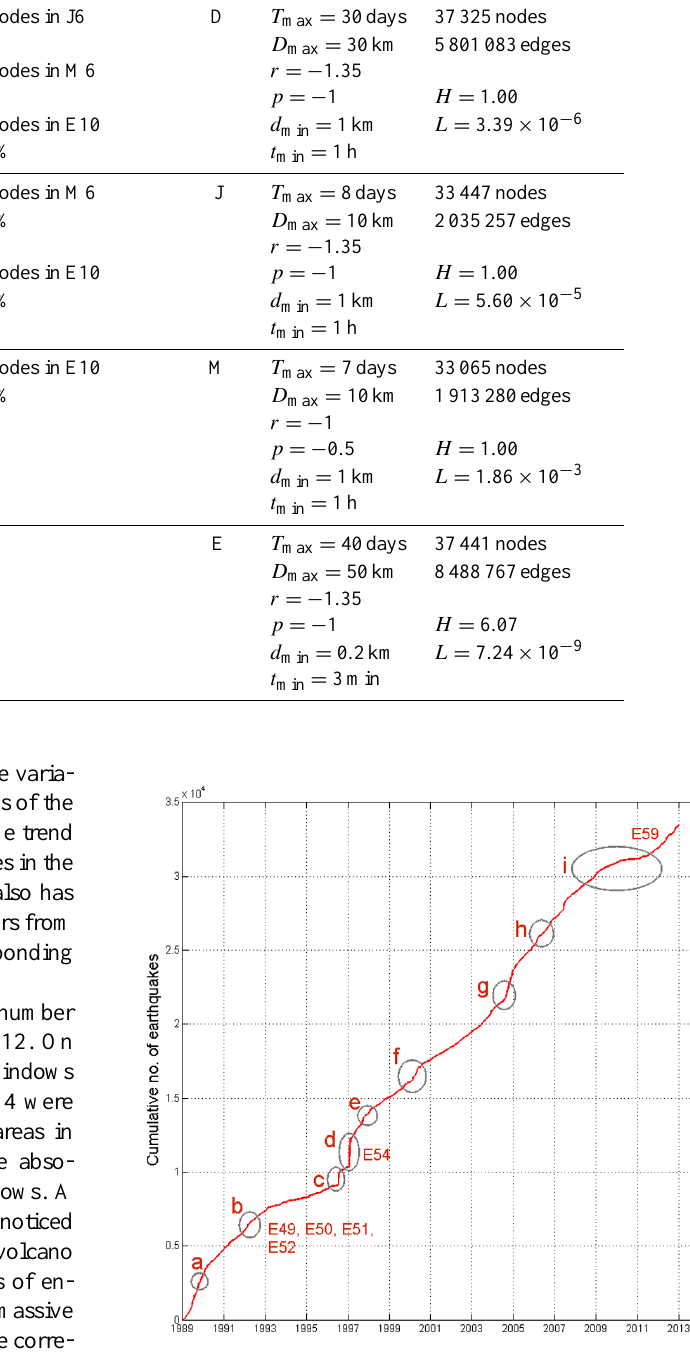
Table 4. Robustness of the method: regardless of various choices of parameter values shown under column “Class definition”, the method identifies the same statistical population of events as being the earthquakes that are interconnected. In this example, the overlap between the nodes selected by networks D9, J6, M6, and E10 ranges between 91.34 and 100%. Network Network characteristics Comparative node selection